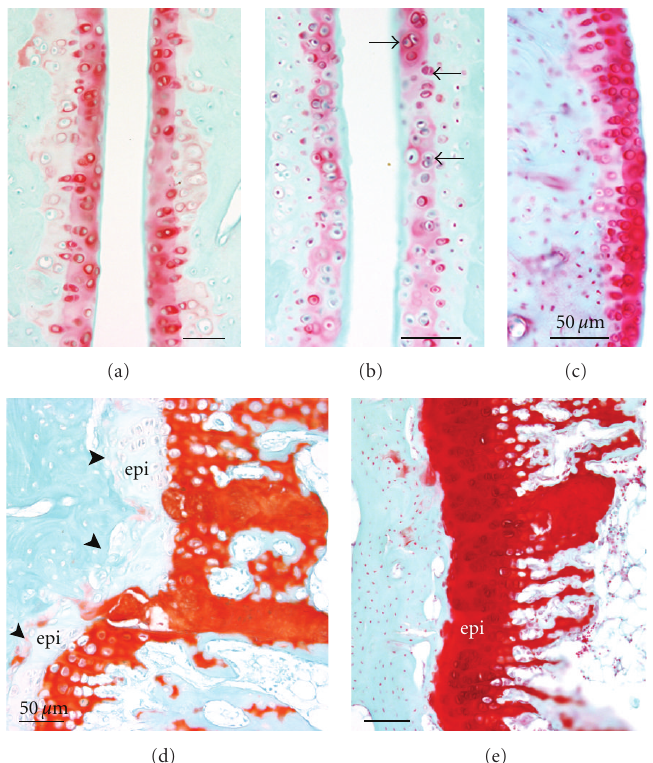
Figure 6: Carpal bone articular cartilages (intracarpal joints) and epiphyseal plates from longitudinal sections of para ffi n embedded bone that were stained with safranin O and fast green. (a)–(c) Carpal bone articular cartilages in (a) TR (trained controls), (b) HRHF (rats performing high-repetition high-force task for 12 weeks), and (c) HRHF + IBU (HRHF rats receiving ibuprofen treatment in final 8 weeks). Reduced safranin O staining and a paucity of cells in lower cartilage layers are present in an HRHF rat, compared qualitatively to TR and HRHF + IBU. Chondrocytes that appear to be proliferating are present in the HRHF carpal articular cartilage (arrows). (d)-(e) Distal epiphyseal plate of the radius showing (d) an HRHF rat with a near absence of safranin O staining (arrowheads) and an irregularly shaped epiphyseal plate, as compared to (e) HRHF + IBU rat with an intensely stained and thicker epiphyseal plate. Scale bars = 50 μ m. epi: epiphyseal